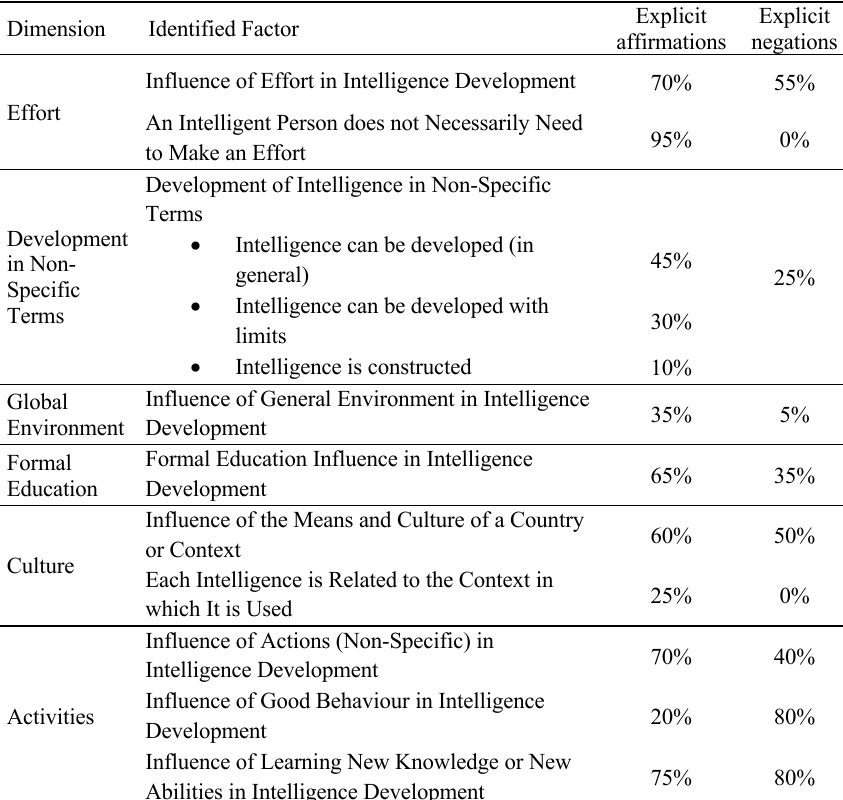
Global data of university teaching staff. Data refer to percentages of participants across the whole samples